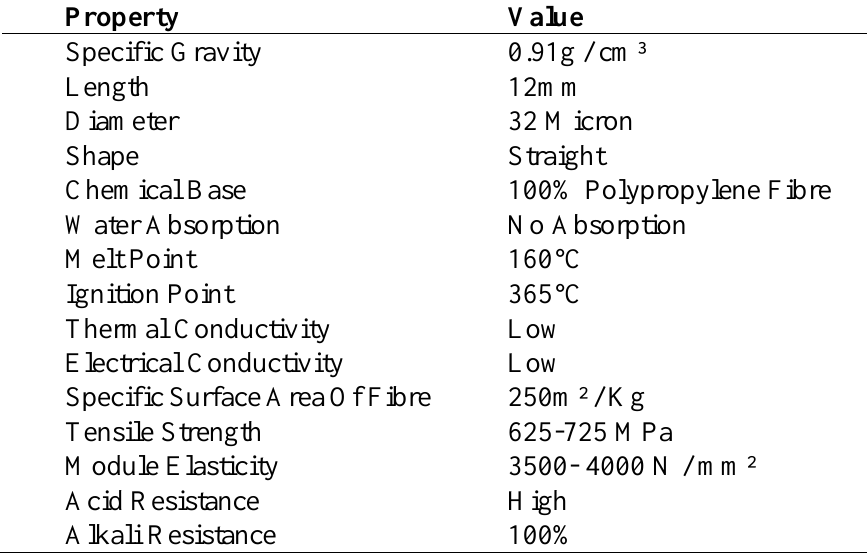
Table. 2 Properties of polypropylene